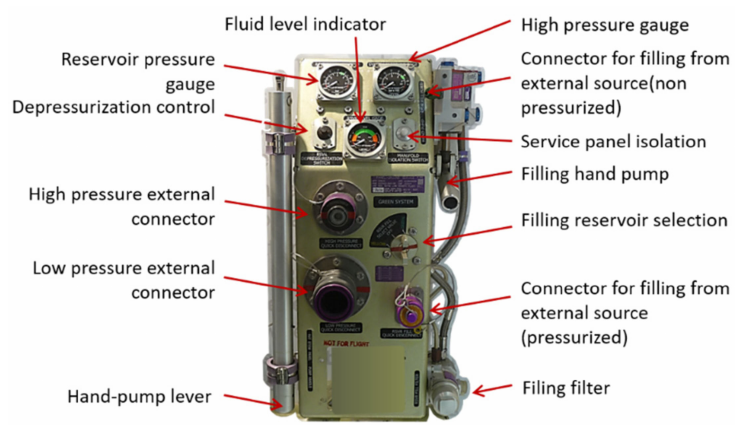
Figure 5. The hydraulic ground service panel of the Airbus